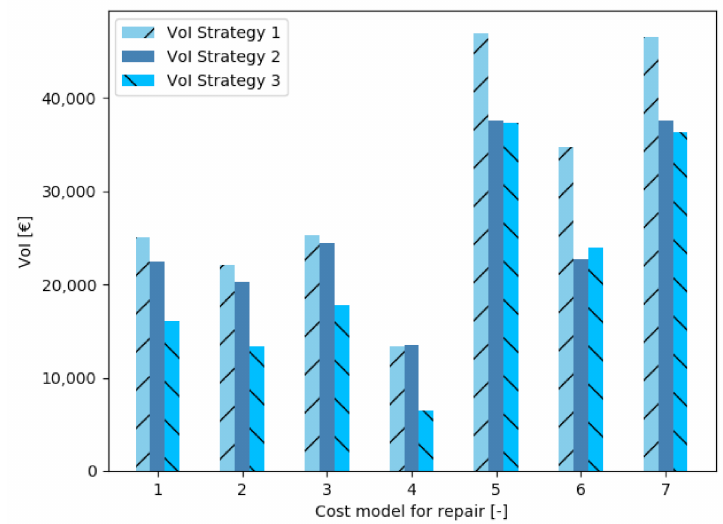
Figure 10. Influence of the cost model for repair on the VoI for the three considered monitoring strategies (for the strategies, reference is made to Table 2).